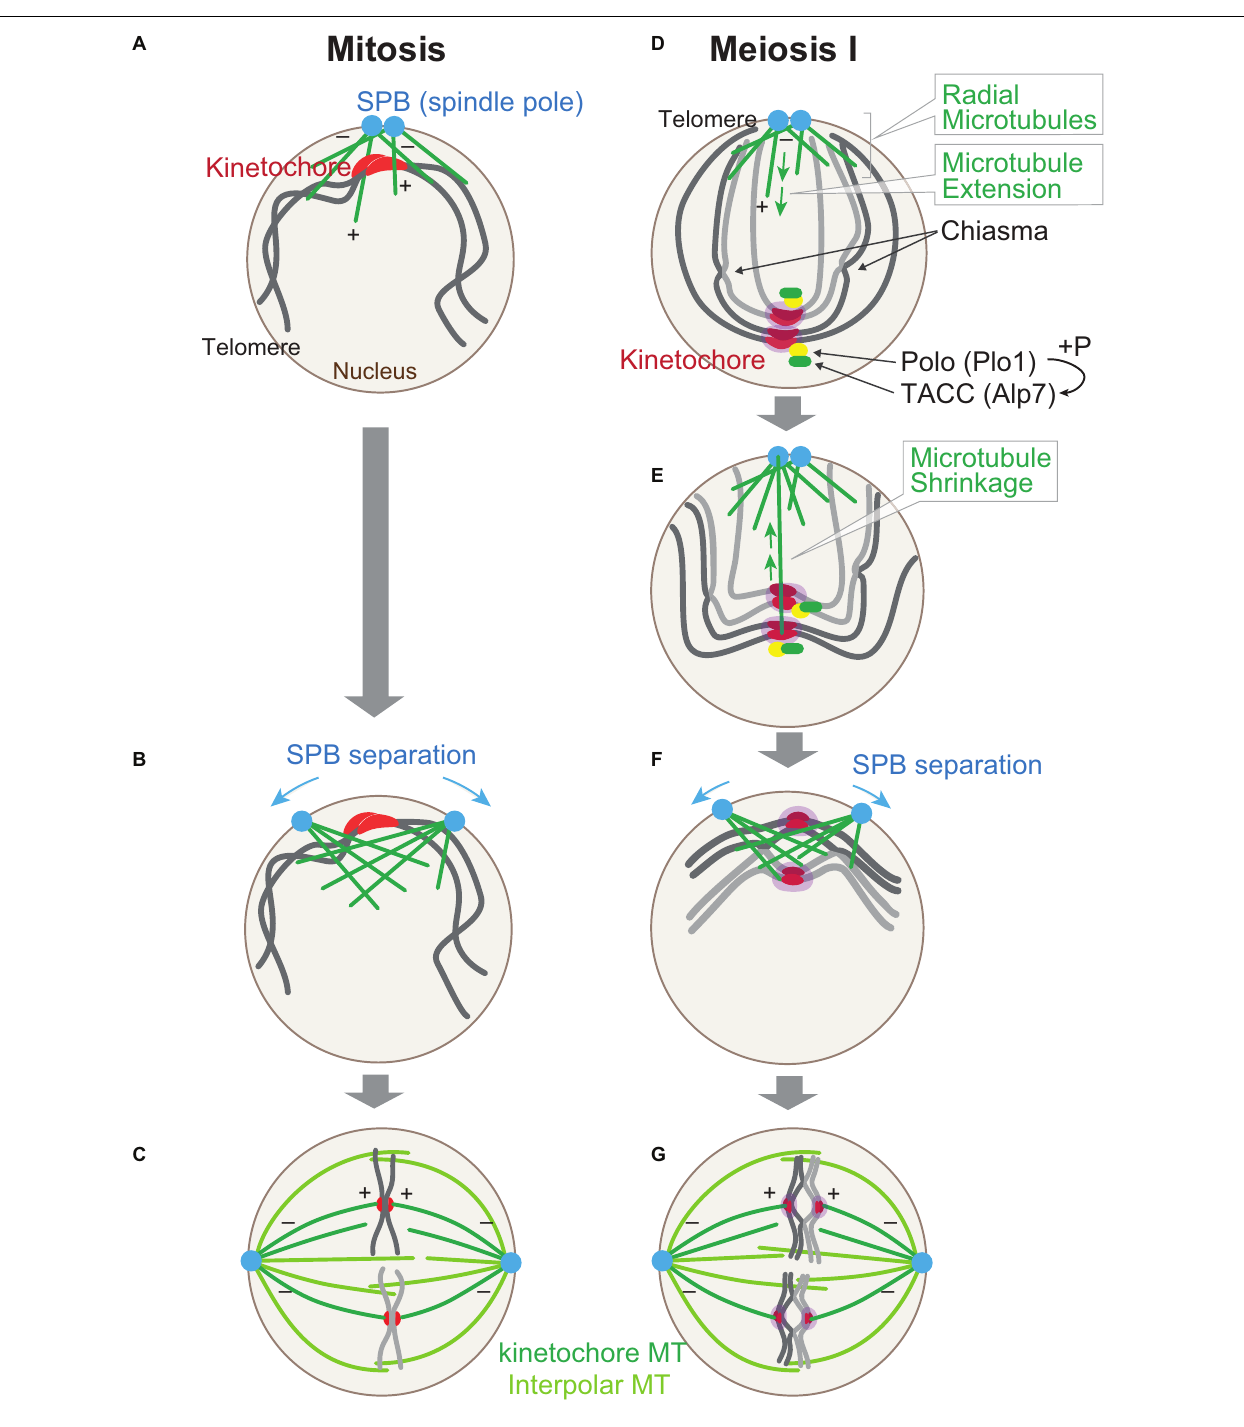
Frontiers in Cell and Developmental Biology |